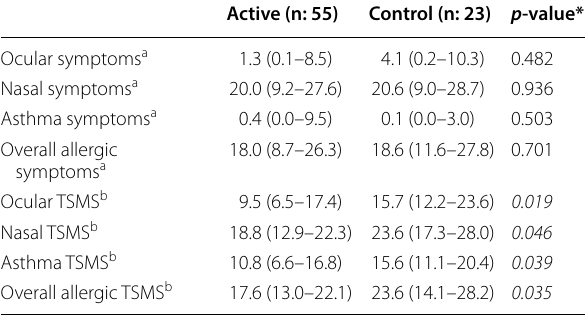
Table 3 Ocular, nasal, asthma and overall allergic